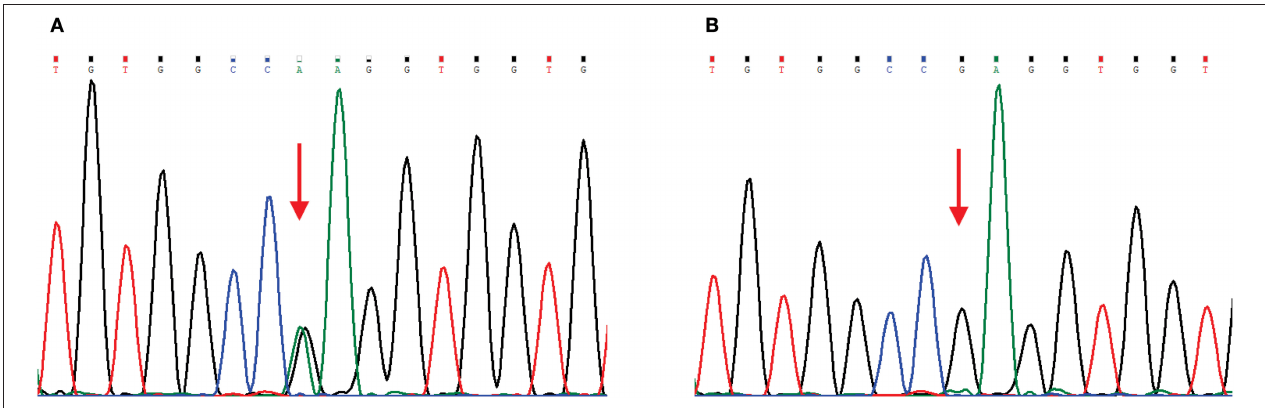
FIGURE 2 | Chromatograms of a GJB1 mutation. Red arrows indicate the mutation site. (A) Sequencing chromatogram of the proband showing heterozygous missense mutation c.622G > A, (p.Glu208Lys) in GJB1 . (B) Sequencing chromatogram of the proband’s husband is